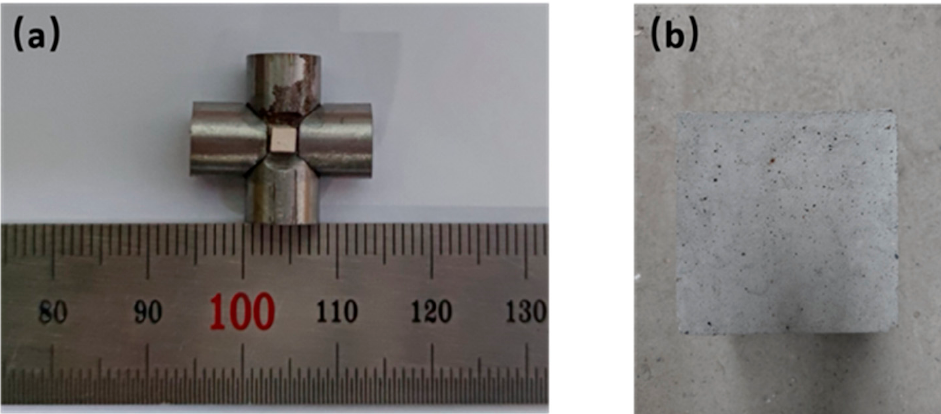
Figure 1. Wave-absorbing concrete samples: ( a ) unit cell of the metamaterial absorber sample; ( b ) optical image of EMW absorbing concrete sample.